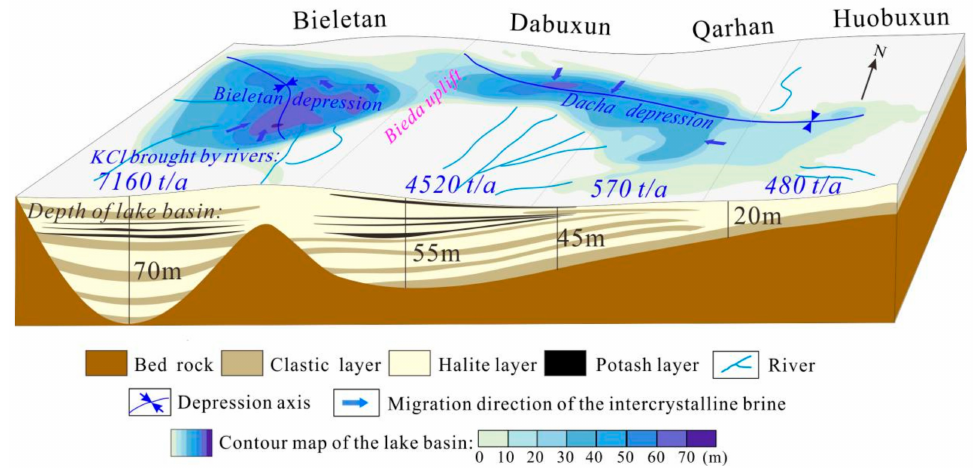
Figure 9. Map showing the isobath of lake basin and the source and enrichment mechanism of KCl in the